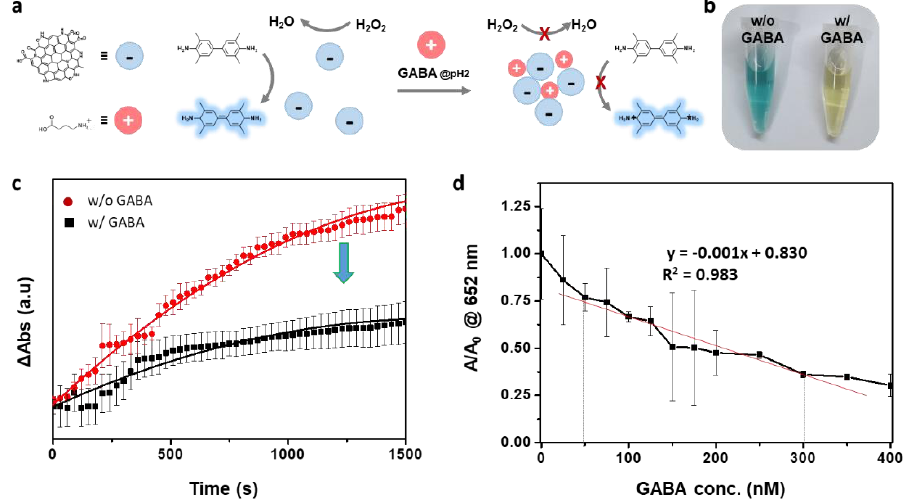
Figure 4. ( a ) Schematic of γ -aminobutyric acid (GABA) detection using Mn:N-CDs. ( b ) Images of TMB/H 2 O 2 /Mn:N-CDs solutions with or without GABA. ( c ) Kinetic curves of Mn:N-CDs with and without GABA for monitoring the catalytic oxidation of TMB (0.15 M citric acid buffer, pH = 2) with 100 mM H 2 O 2 . ( d ) Variation in absorption (at 652 nm) of the mixed solution containing Mn:N-CDs, GABA, TMB, and H 2 O 2 as a function of the concentration of GABA.